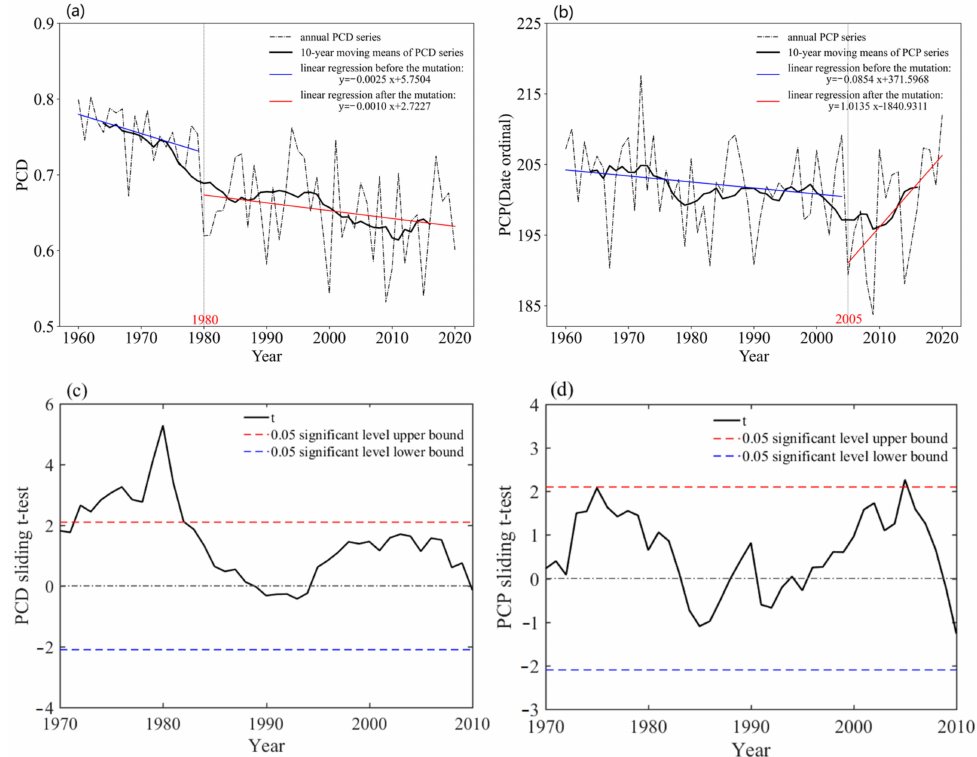
Figure 2. Moving t -test schematics of ( a ) PCD and ( b ) PCP; (The dashed line is the annual PCD/PCP series, the black solid line is the 10-year moving average, and the blue (red) solid line shows the linear regression before (after) the mutation point) and the t values of ( c ) PCD and ( d ) PCP (The black solid lines represent the t-values, and the red (blue) dashed lines represent the 0.05 significance upper (lower)